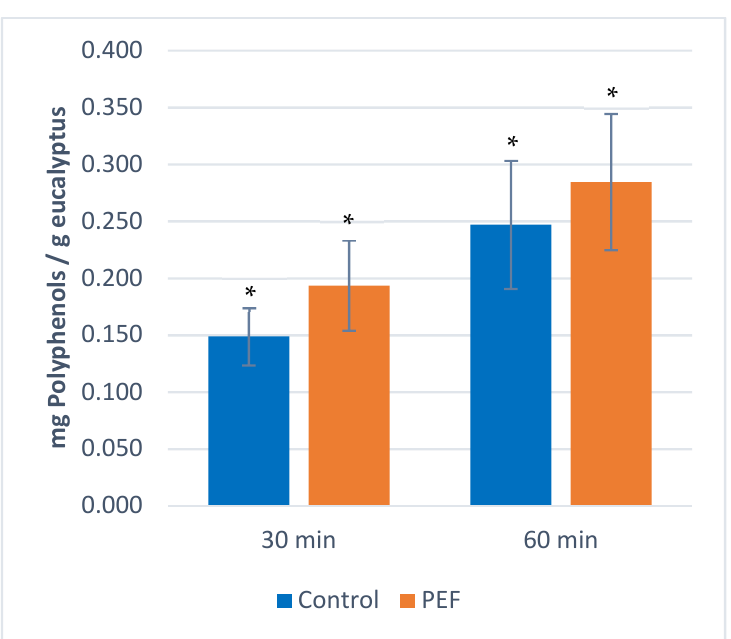
Figure 6. Results for TPC analysis of eucalyptus with (PEF) and without PEF application (Control) and different distillation times, phenols (mg/g eucalyptus). Vertical lines refer to the STDev. * Indicates statistical significance ( p -value < 0.05).